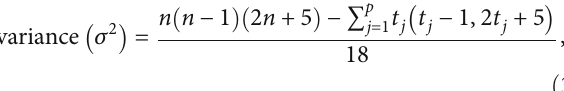
Table 1: Residential house electrical equipment and daily load